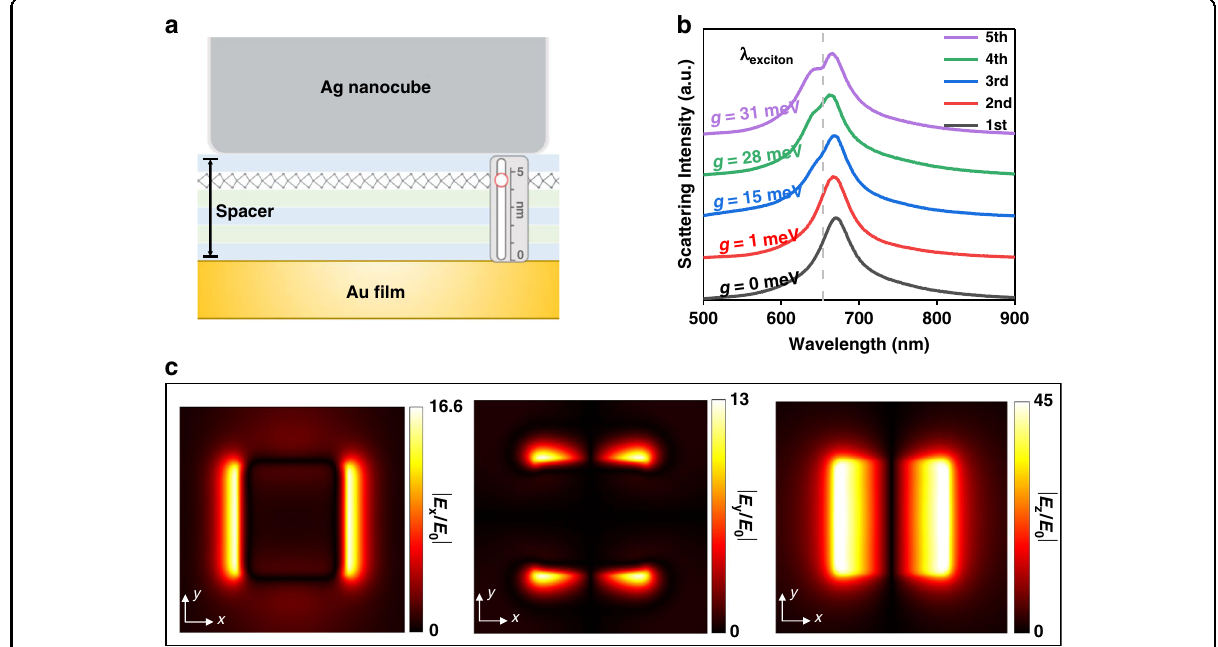
Fig. 3 The dark- fi eld scattering spectrums study and theoretically calculation for electromagnetic fi eld distribution of plasmon-exciton system with the same thickness PE layers. a Schematic diagram of MoS 2 at the above nanocavities with the thickness of 5 PE layers. b The dark- fi eld spectrum of nanocavities was measured with different positions of MoS fi eld in the XY 2 . c Distribution of the x, y, z-component of the electric planes situated at 5th position in Fig. 3a with MoS 2 is background index-only material, normalized to the incident electric fi